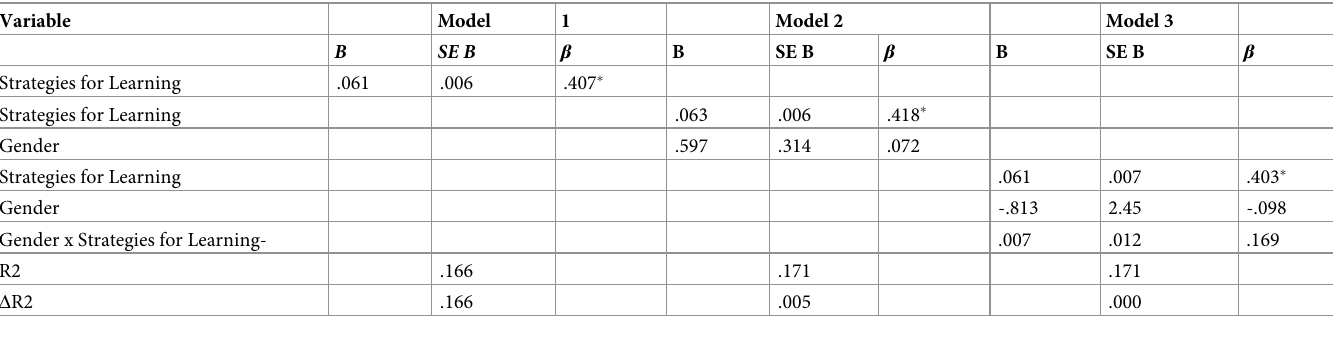
Table 4. Summary of hierarchical regression analysis for gender moderation of self–Motivated strategies for learning and self-perceived employability. Variable Strategies for Learning